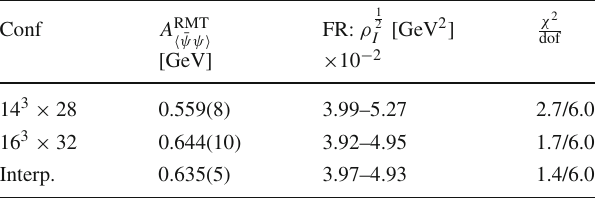
Table 12 The fitting results obtained by the linear curves (cid:5) ¯ ψψ (cid:6) = 1 − A RMT 2 x , ( x = ρ , [ GeV 2 ] ). The configurations of the lattice volumes (cid:5) ¯ ψψ (cid:6) I V = 14 3 × 28 and V = 16 3 × 32 of β = 6 . 0000 and the interpolated results are used